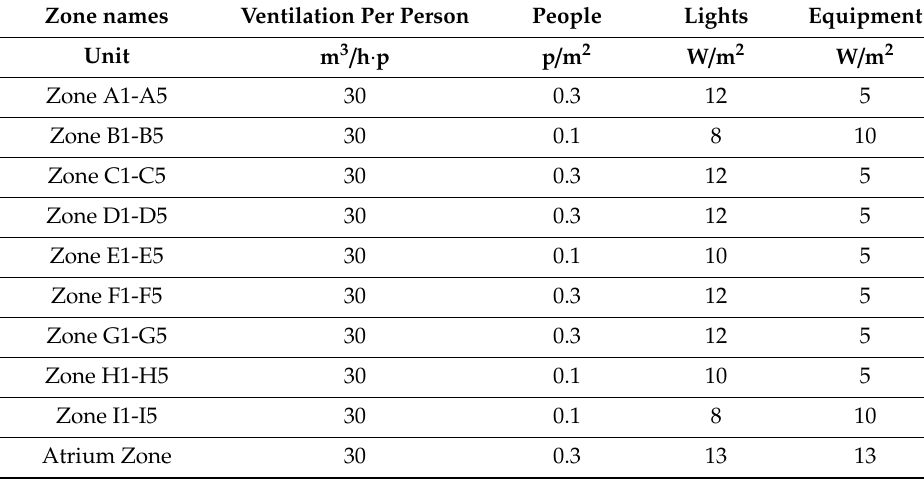
Table 4. Zone load Table 4. Zone load parameters.